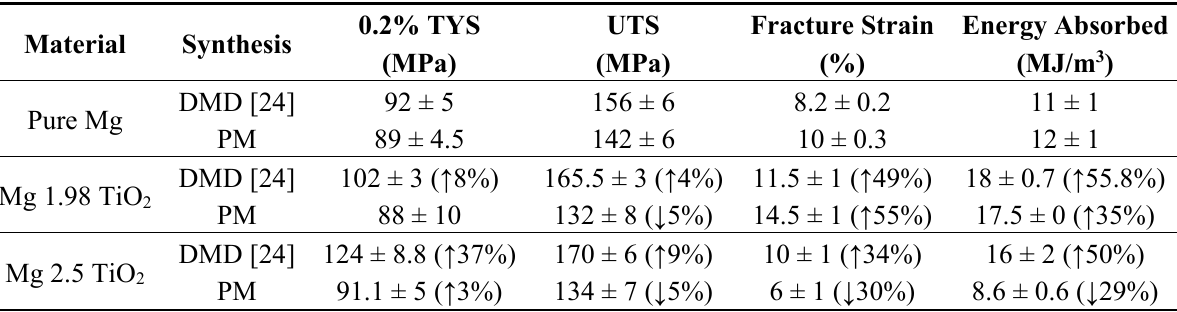
Table 5. Results of room temperature tensile